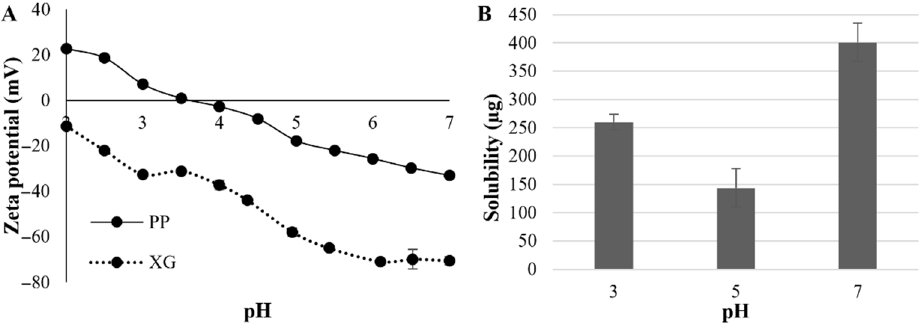
Figure 1. Zeta potential of pea protein (PP) and xanthan gum (XG) ( A ) and Protein solubility ( B ).